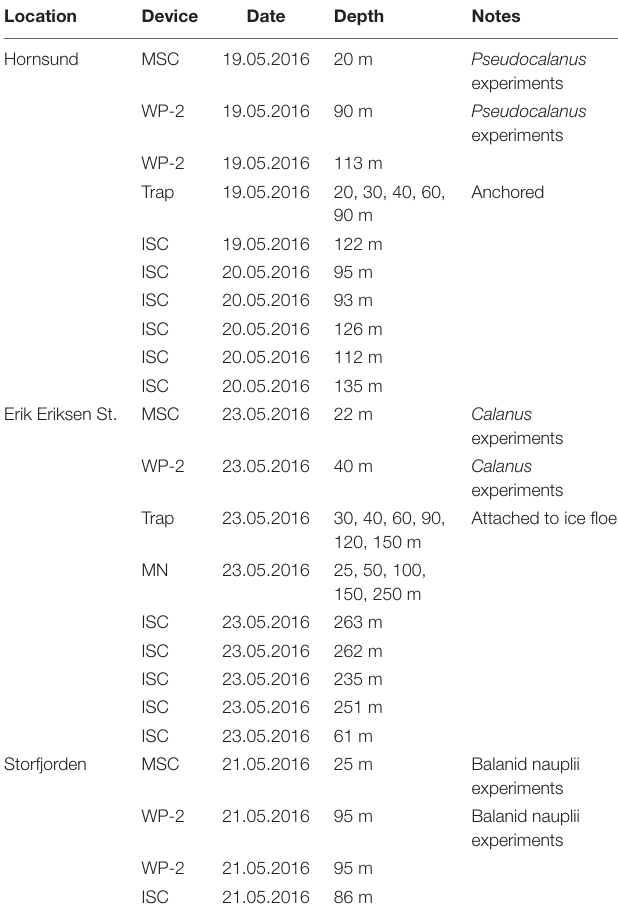
TABLE 1 | Overview of the deployments of the marine snow catcher (MSC), WP-2-net, sediment trap, in situ camera (ISC), and MultiNet